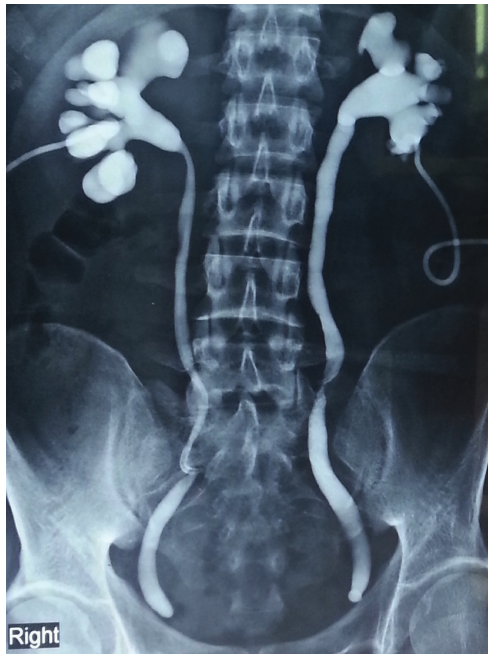
figure 1 - Nephrostomogram showing complete cut off at the level of lower ureter on both sides (done after being operated elsewhere).